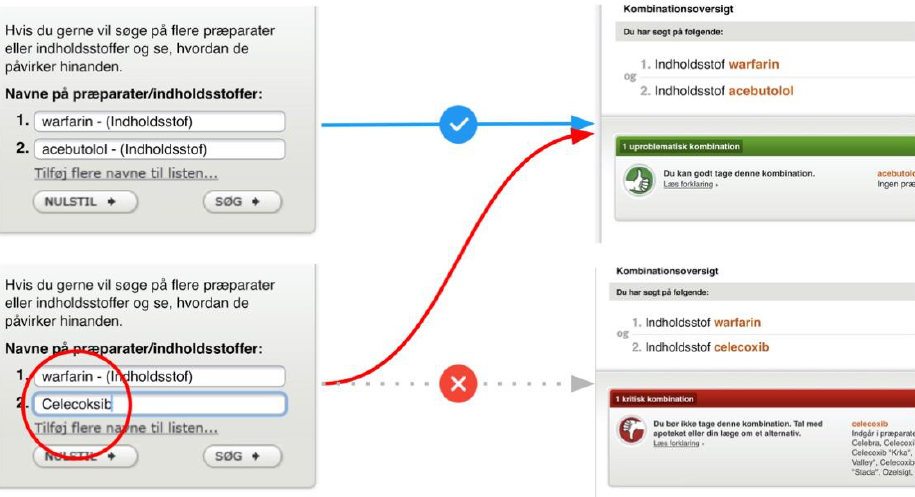
Figure 17. Medicinkombination.dk providing previous results for a current search.